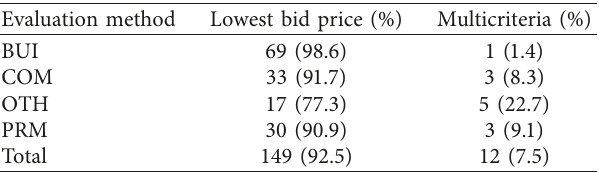
Table 6: Contingency table for the evaluation method used in e-RA auctions stratified by the type of